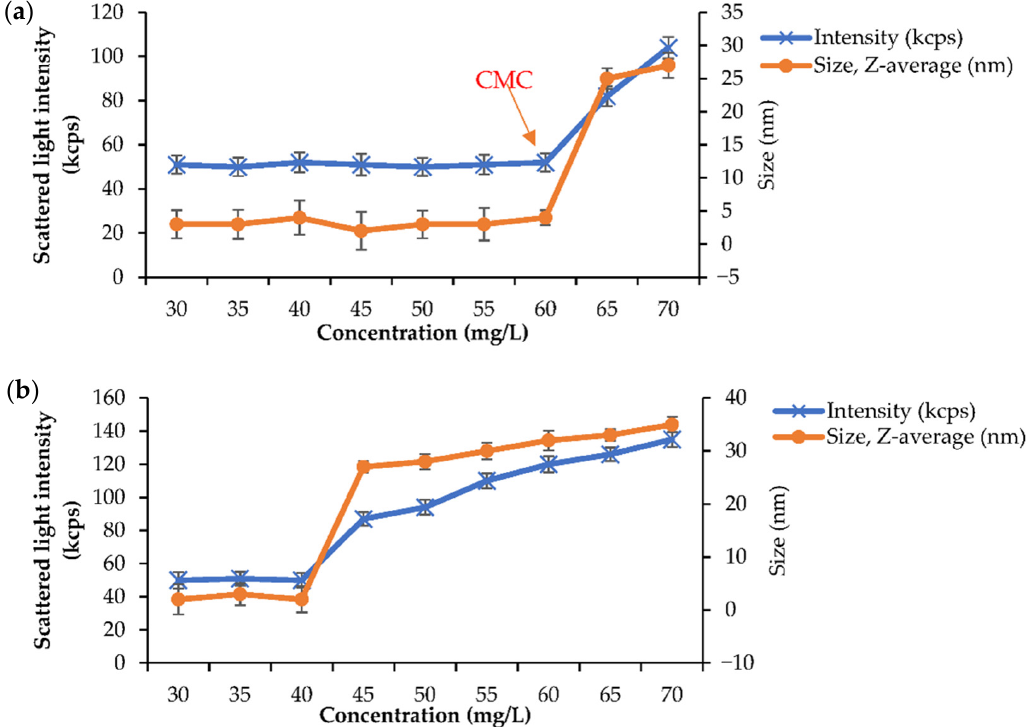
Figure 8. Scattering light intensity as a function of the concentration (range 30–70 mg/L) for BMO-PUL derivatives with different DG: ( a ) 12.6% and ( b ) 33.8% ( n = 3; ± SD).